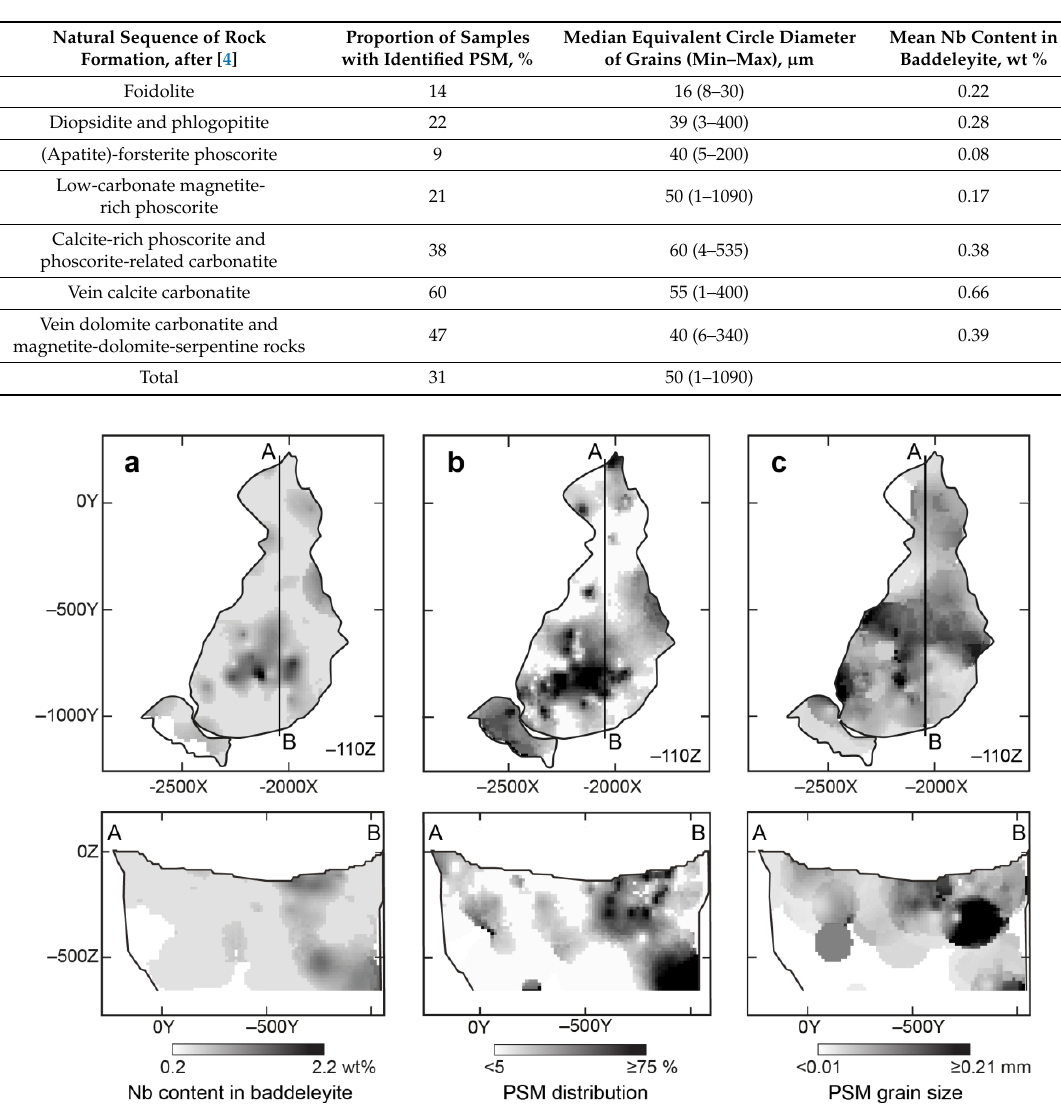
Figure 1. Distributions of Nb in baddeleyite ( a ), PSM-bearing rocks ( b ) and average size of PSM grains in a sample ( c ) within the Kovdor phoscorite-carbonatite complex.